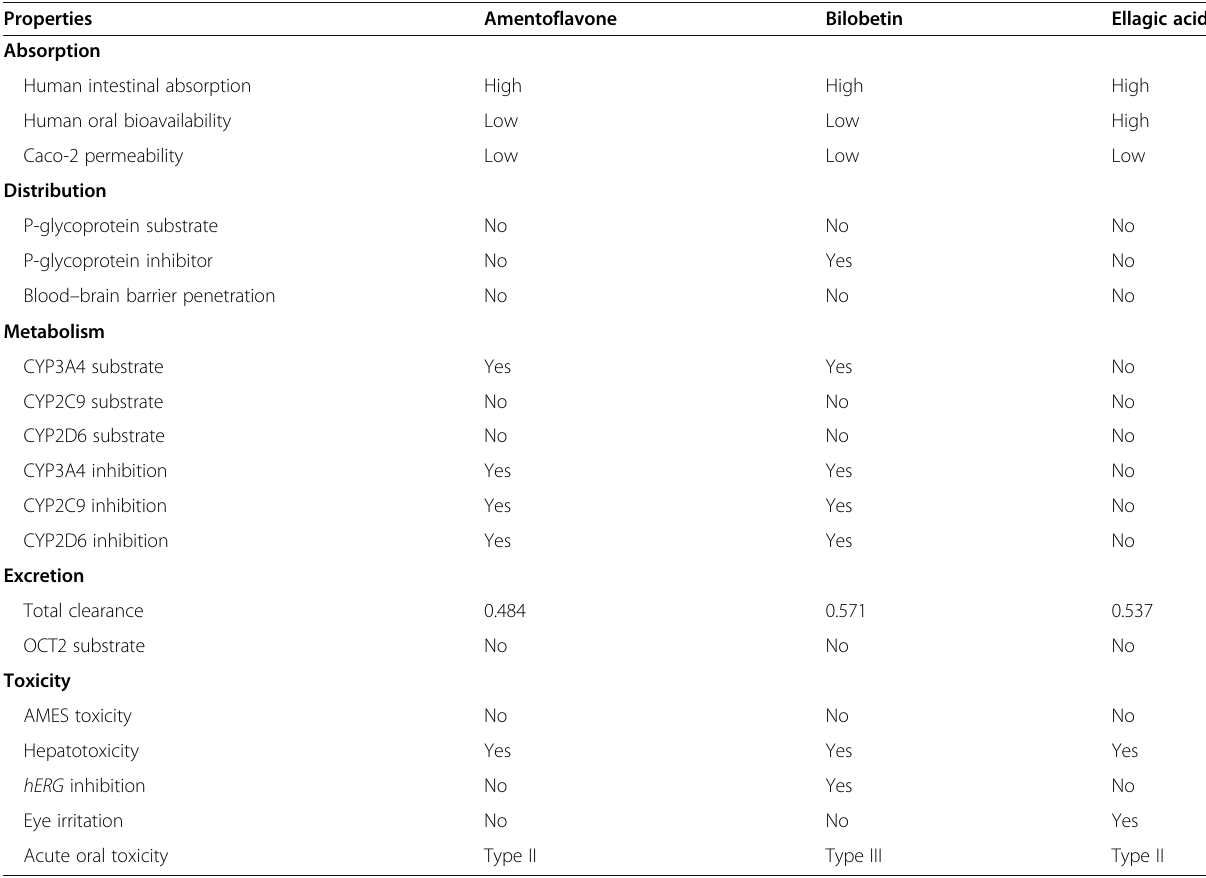
Table 5 Results of ADME/T tests of best-selected ligands. OCT2 organic cation transporter 2, hERG human ether-a-go-go-related